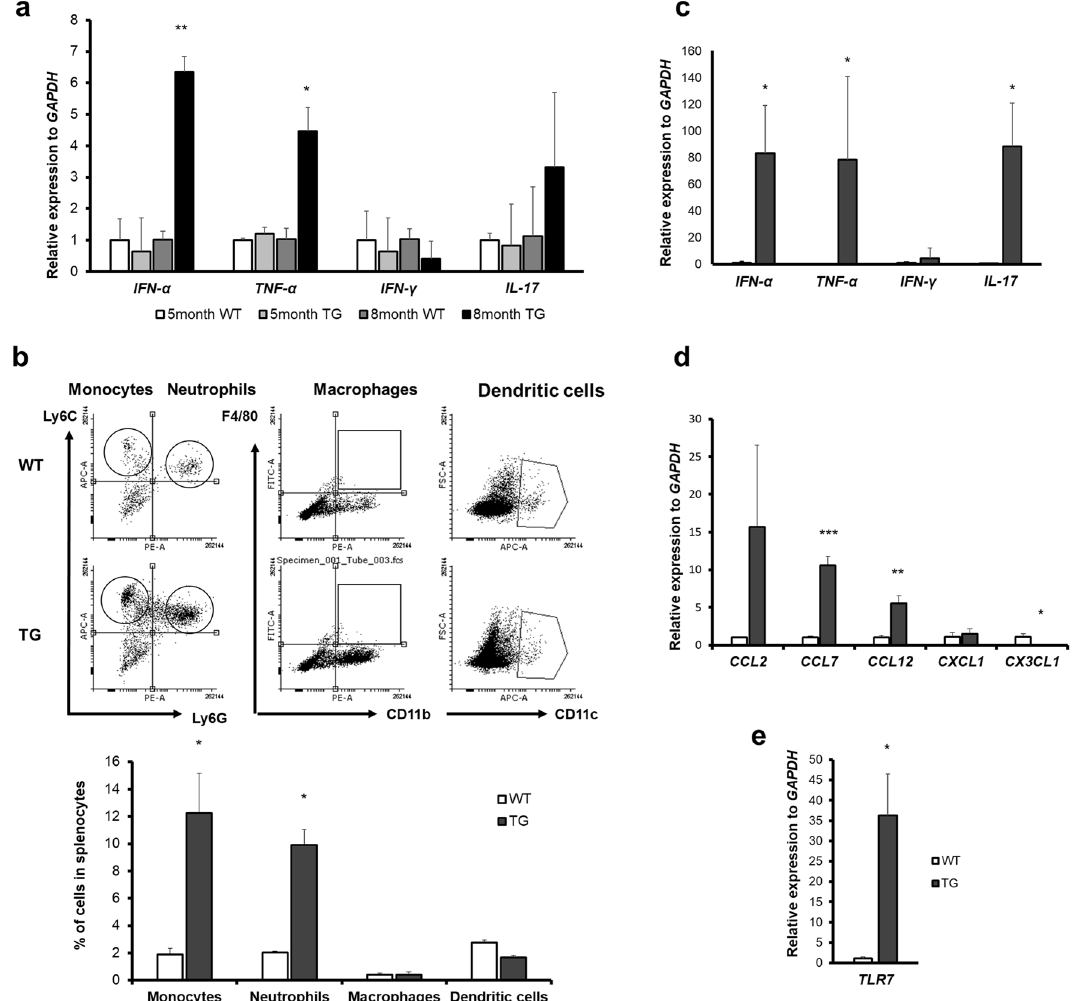
Figure 2. Generation of spontaneous inflammation in 8-month-old transgenic (TG) mice. ( a ) mRNA levels of cytokines ( IFN-α , TNF-α , IL-17 and IFN-γ ) in the spleens of 5- and 8-month-old WT and TG mice measured by qRT-PCR. ( b ) Flow cytometric analysis of single cells from the spleens of 8-month-old mice. (( b ), upper) A strategy to determine the population of monocytes, neutrophils, macrophages and dendritic cells is represented. To investigate the population of monocytes and neutrophils, CD11b + cells were gated first. Ly6C + Ly6G + cells were considered to be neutrophils, and Ly6C + Ly6G - cells were considered to be monocytes. CD11b + F4/80 + cells served as macrophages, and CD11c + cells represented neutrophils. (( b ), lower) Monocyte, neutrophil, macrophage and dendritic cell populations are represented. ( c ) mRNA levels of cytokines IFN-α , TNF-α , IL-17 and IFN-γ , ( d ) mRNA expression levels of chemokines CCL2 , CCL7 , CCL12 , CXCL1 and CX3CL1 . ( e ) TLR7 mRNA expression levels in the kidneys of 8-month-old WT and TG mice, measured by qRT-PCR. WT, wild type. * p < 0.05; ** p < 0.01, *** p < 0.001 versus WT group of the same